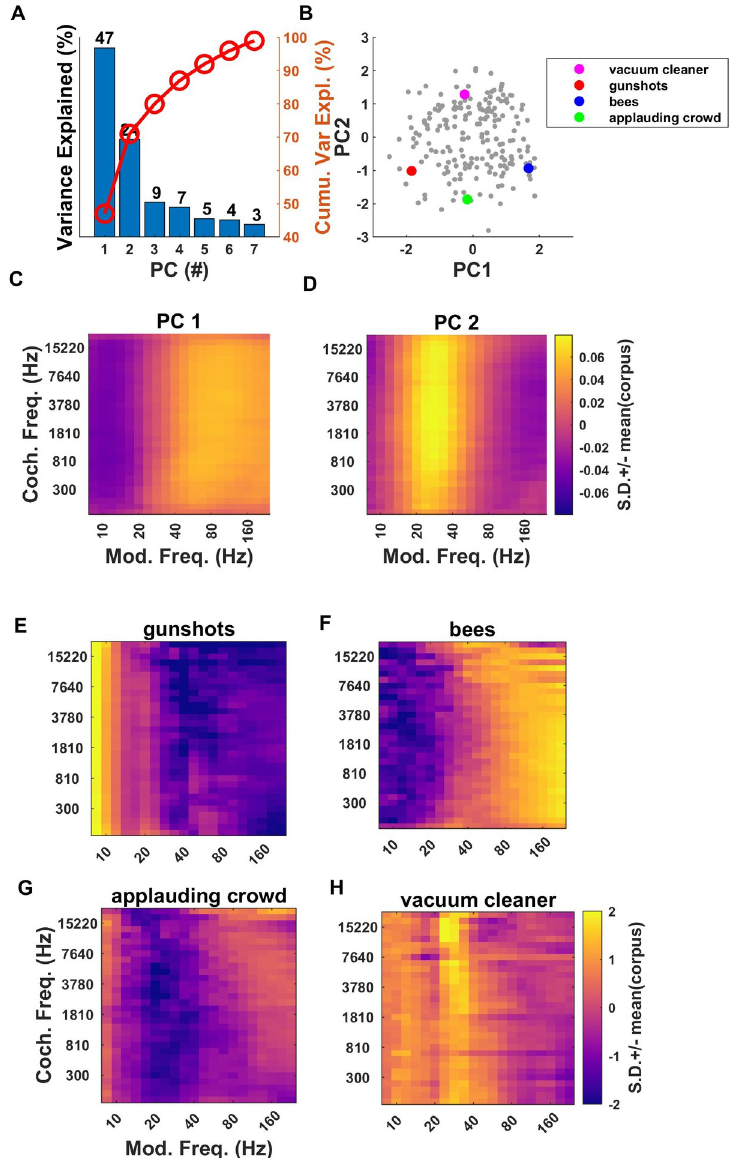
Fig 10. Principal components of the modulation parameters. (A) Proportion variance explained by the first seven PCs of modulation power parameters. Percentage of cumulative variance is indicated by the red line. (B) Distribution of sound textures from our corpus along the first two PC coordinates for modulation power. The first two PCs capture ~71% of cumulative variance. (C, D) Shape of first and second PC respectively. PC1 discriminates sounds “slowly” from “rapidly” modulating sounds, with a boundary near 60 Hz for all cochlear frequencies. PC2 discriminates sounds with prominent modulations in a “mid range” (near 60 Hz) from sounds lacking such modulations. (E) Modulation spectrum of sound texture sample “Gunshots”, showing prominent modulation at low rates. (F) Modulation spectrum for “bees”. High modulation frequencies ( > ~80 Hz) dominate. (G, H) The modulation spectrum for “Applauding Crowd” shows a relative dearth of modulations near 60 Hz, while that for “Vacuum Cleaner” shows prominent ~60 Hz